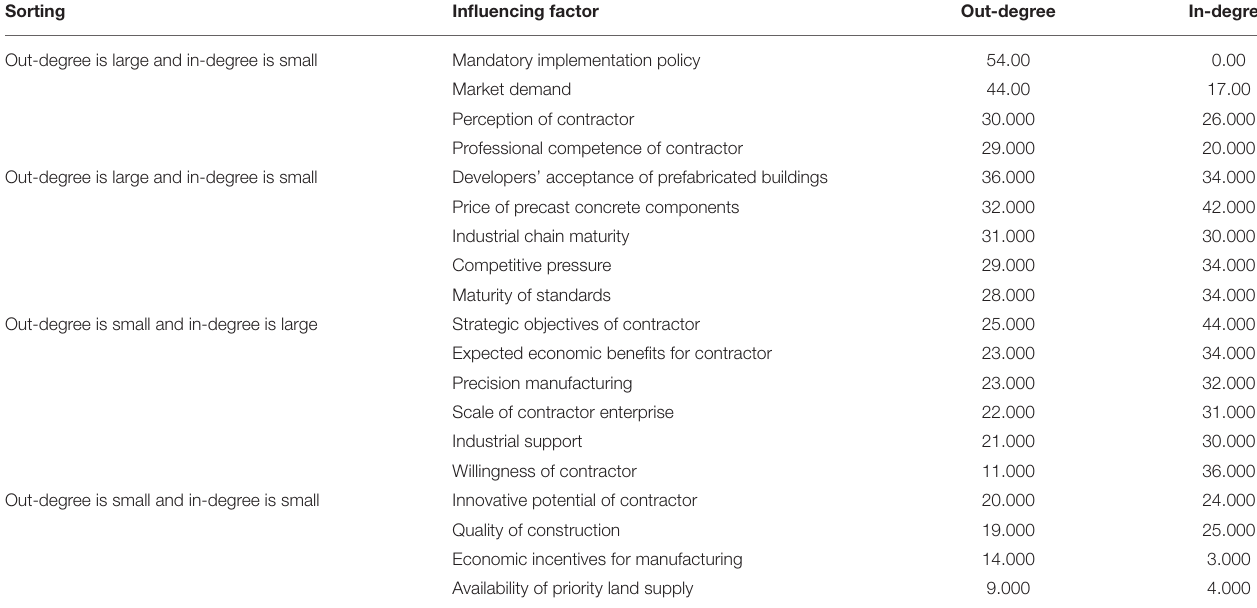
TABLE 2 | Analysis results of degree centrality for influencing